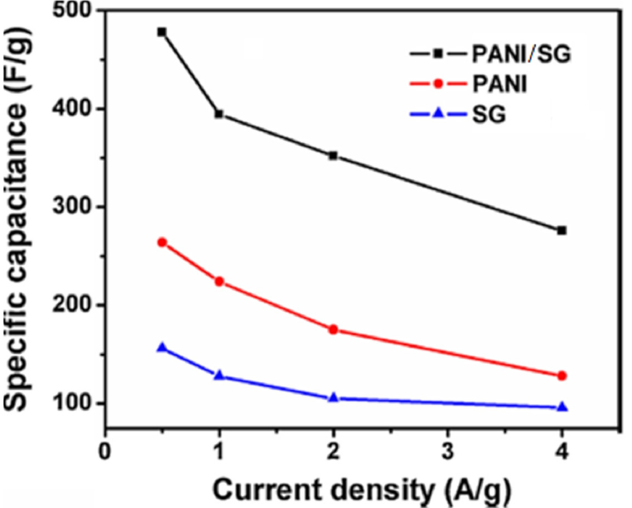
Figure 10. Variation of the specific capacitance with current density for SG paper, PANI powder, and PANI/SG paper [70]. PANI = polyaniline; SG = sulfonated graphene.